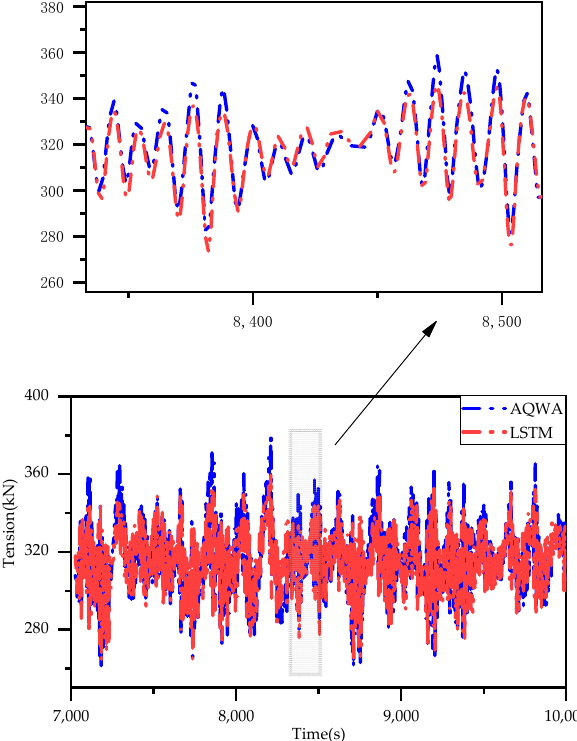
Figure 5. Mooring Line 2 tension comparison under Case 1. Table 10. Result statistics of mooring tensions in Case 1.